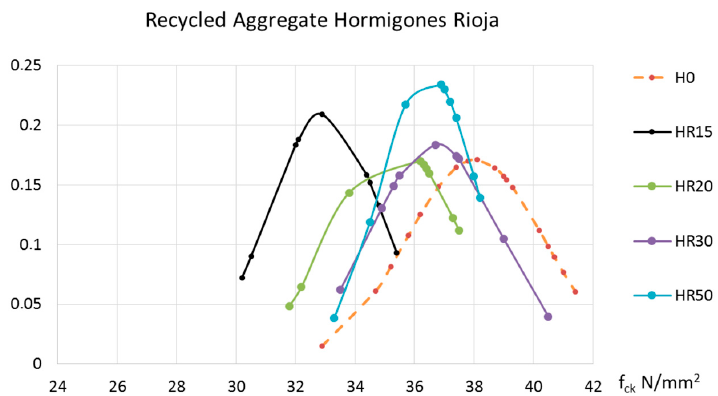
Figure 6. Compressive strength of concrete at an age of 28 days manufactured with recycled aggregates from Hormigones Rioja.